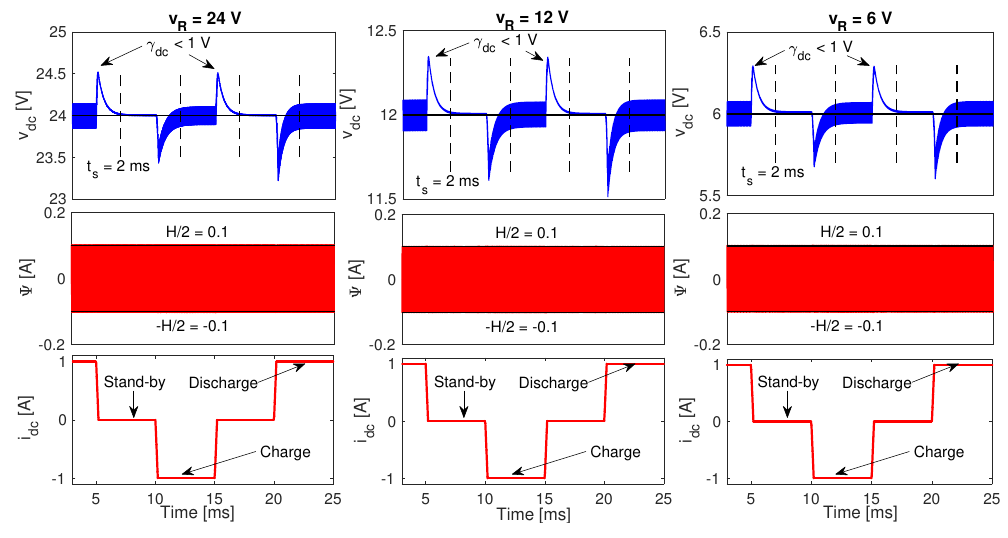
Figure 11. PSIM simulation of the electrical circuit given in Figure